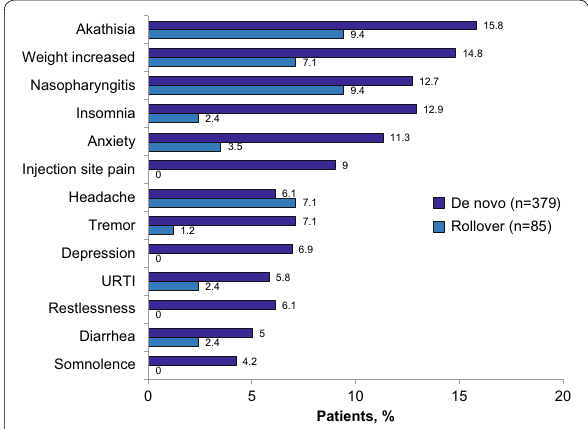
Fig. 2 TEAEs occurring in 5% of patients during the AOM 400 ≥ maintenance phase, by enrollment source. TEAEs displayed from most common overall at top to least common overall at bottom, displayed as percent incidence in de novo and rollover patients. AOM 400 aripiprazole once-monthly 400 mg; TEAE treatment-emergent = adverse event, URTI upper respiratory tract